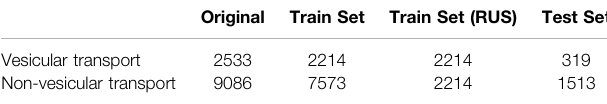
TABLE 1 | Details of the dataset used in our